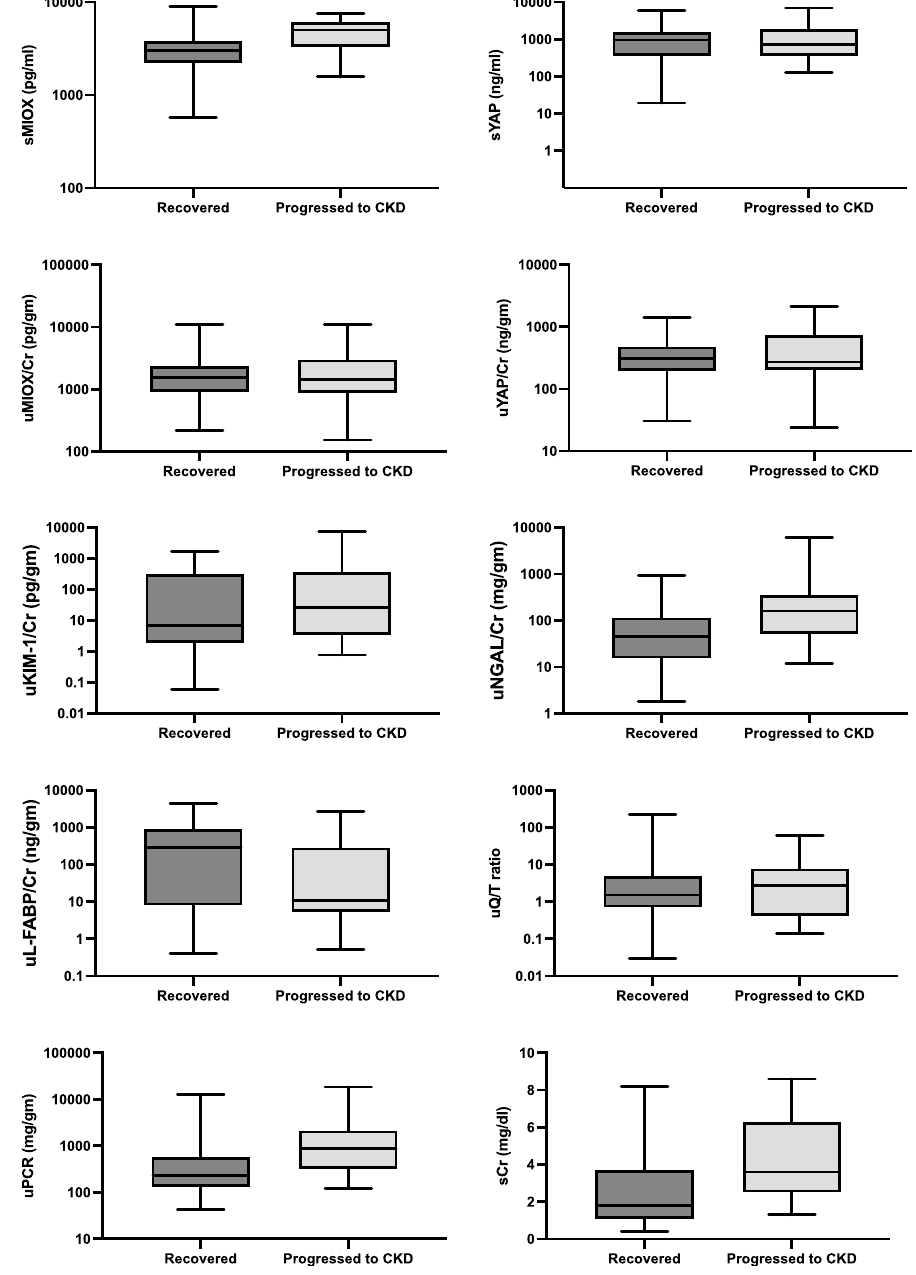
Figure 2. Box and whisker plot showing the levels of serum and urine biomarkers in recovered patients and those who progressed to CKD from CA-AKI. sMIOX serum myo-inositol oxygenase, uMIOX urine myo-inositol oxygenase, sYAP serum Yes-associated protein, uYAP urine Yes-associated protein, uKIM-1 urine kidney injury molecule-1, uNGAL urine neutrophil gelatinase-associated lipocalin, uL-FABP urine liver-type fatty acid binding protein, uPCR urine protein creatinine ratio, sCr serum creatinine, Cr;